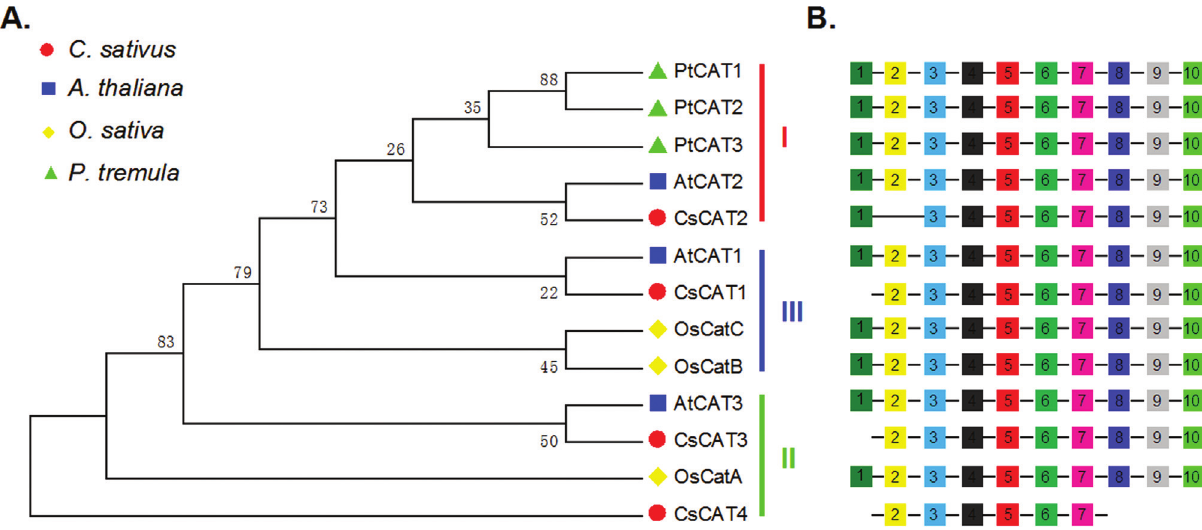
Figure1 -Plantcatalasegenes.(A)Neighbor-joiningtreeforCATsequencesofcucumberandotherspecies.(B)Distributionofconservedmotifsinfour cucumber CsCATs, three rice OsCATs, three Arabidopsis AtCATs, and three poplar PtCAT proteins identified using the MEME search tool. Each motif isrepresentedbyacoloredboxandanumber.Theorderofthemotifscorrespondstothepositionofmotifsinindividualproteinsequences.Detailsregard- ing the motifs are given in Table